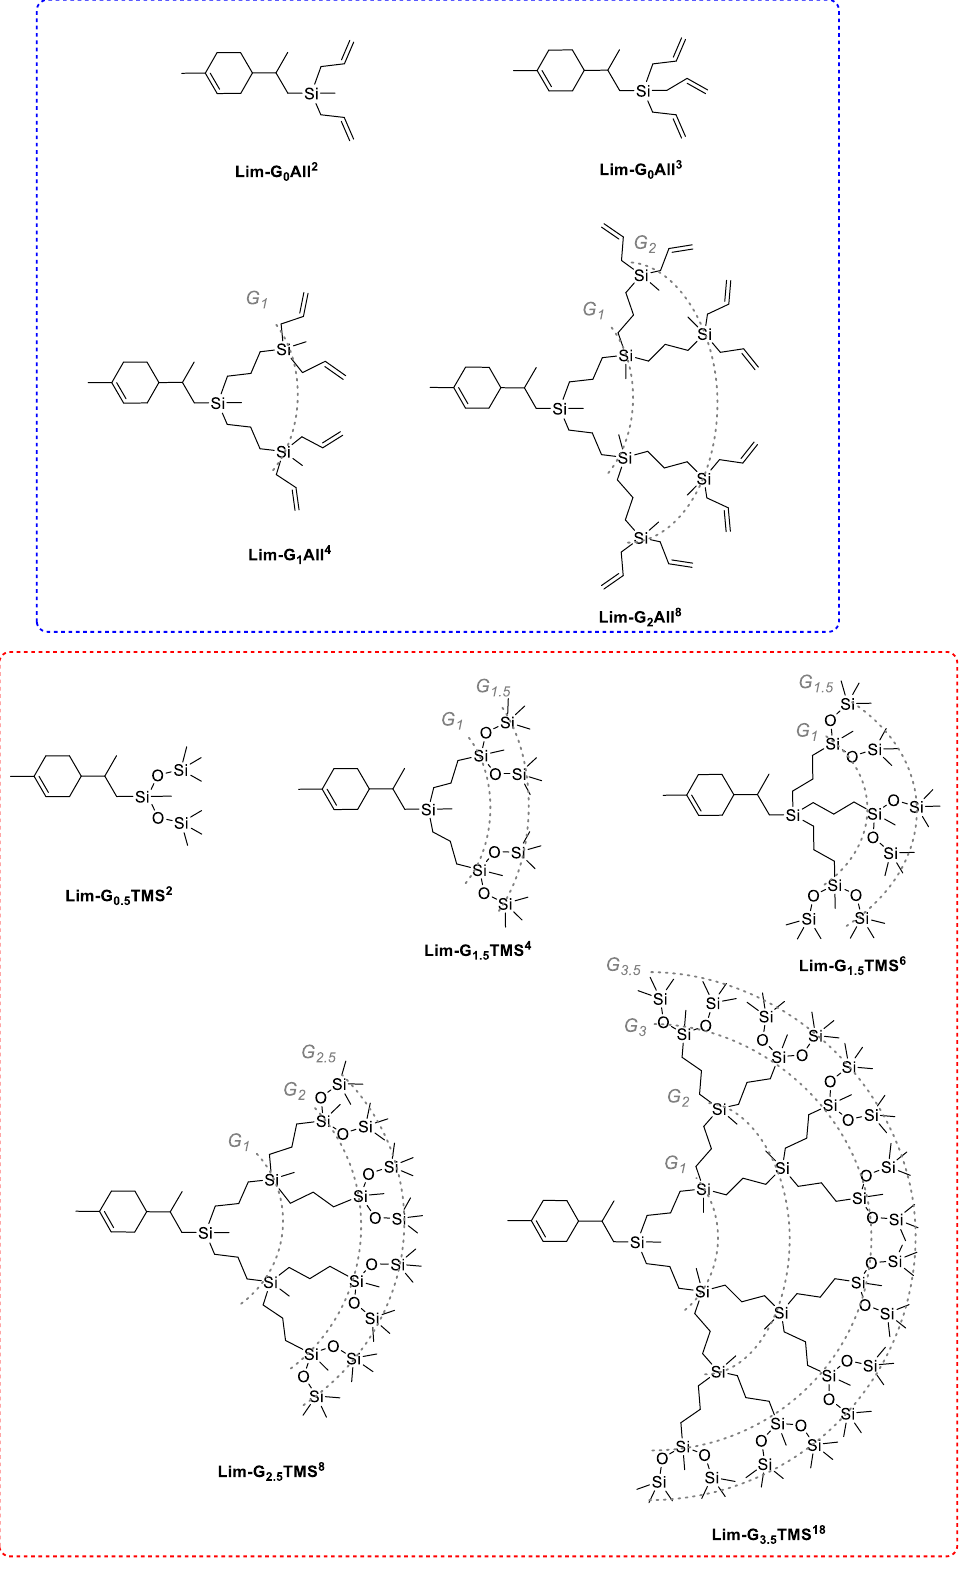
Figure 2. Library of obtained dendrons based on limonene with allyl functionality on the periphery and blocked with